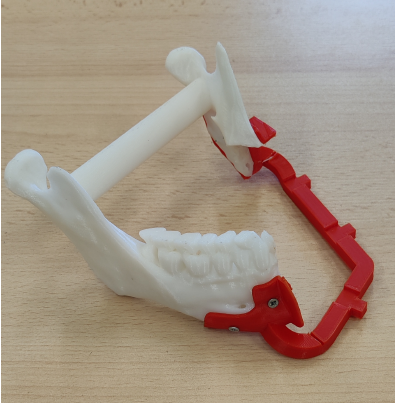
Figure 2. 3D model of the mandibula after the resection. The bone tissue of the fibula should replace the missing part. In red you can see a guide used to keep the bones in place during the surgery.